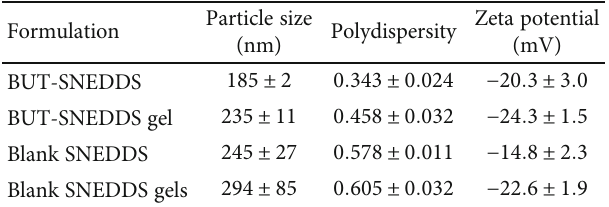
Table 1: Mean particle size, polydispersity, and zeta potential of prepared batches of BUT-SNEDDS and BUT-SNEDDS gel ( n = 4 ).